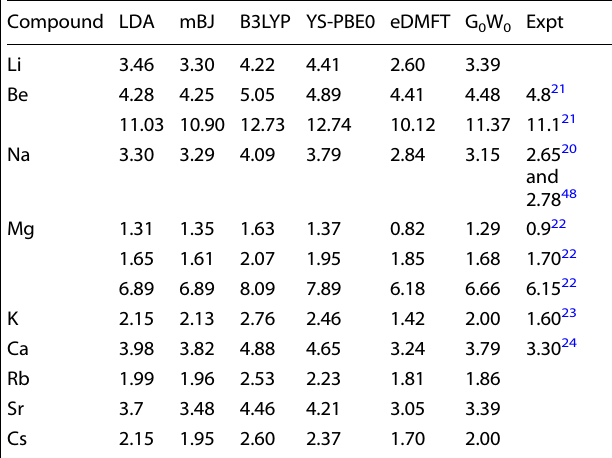
Table 1. Bandwidth (in eV) of occupied bands for various elemental metals as computed in various beyond-DFT approaches and their comparison with available experiments with 0 – 12